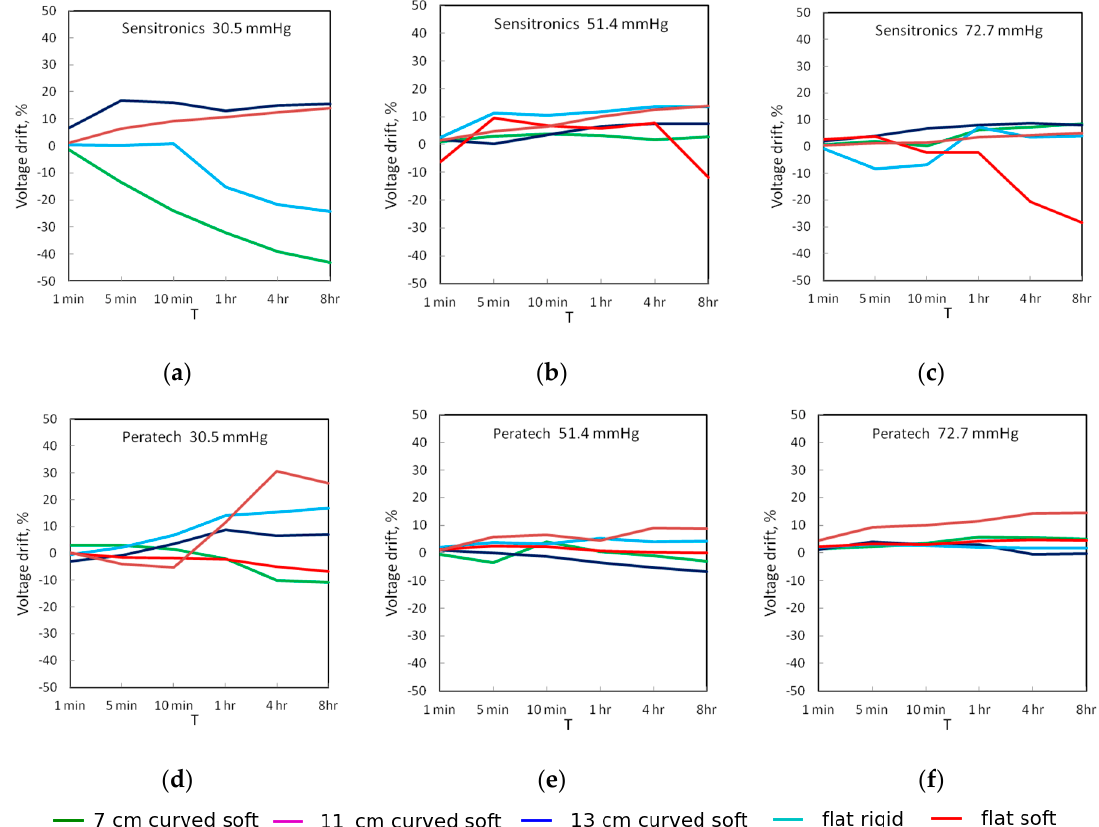
Figure 7. Static drift of output voltage for sensors at the three applied pressures: ( a – c ) Sensitronics; ( d – f ) Peratech.